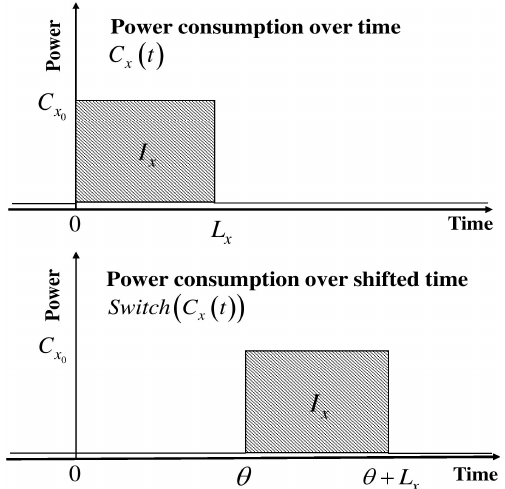
Figure 1. Shifting behavior of the generic load shift model.